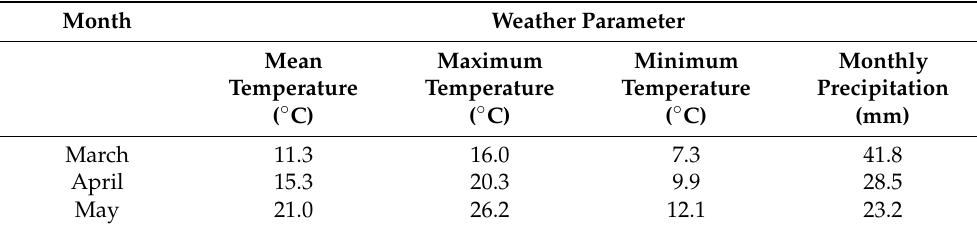
Table 1. Mean, maximum, and minimum monthly temperature ( ◦ C) and monthly total precipitation (mm) prevailed during the experimental